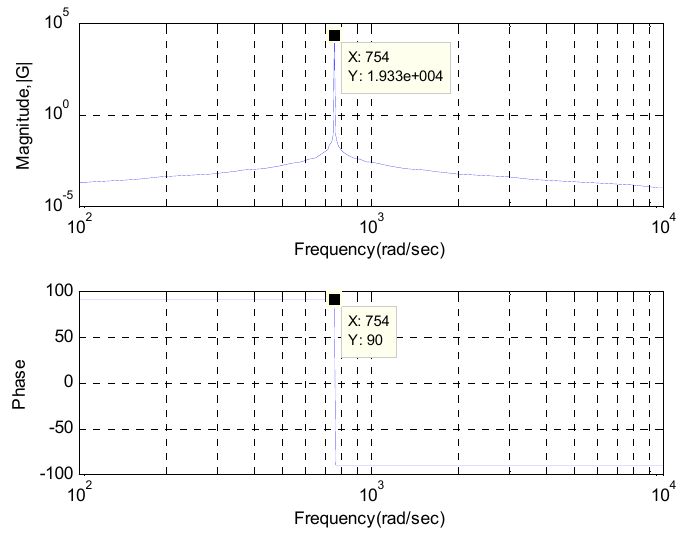
Figure 9. Bode-plot of PR controller tuned for 120 Hz; K = 10 rad/s. and ω c